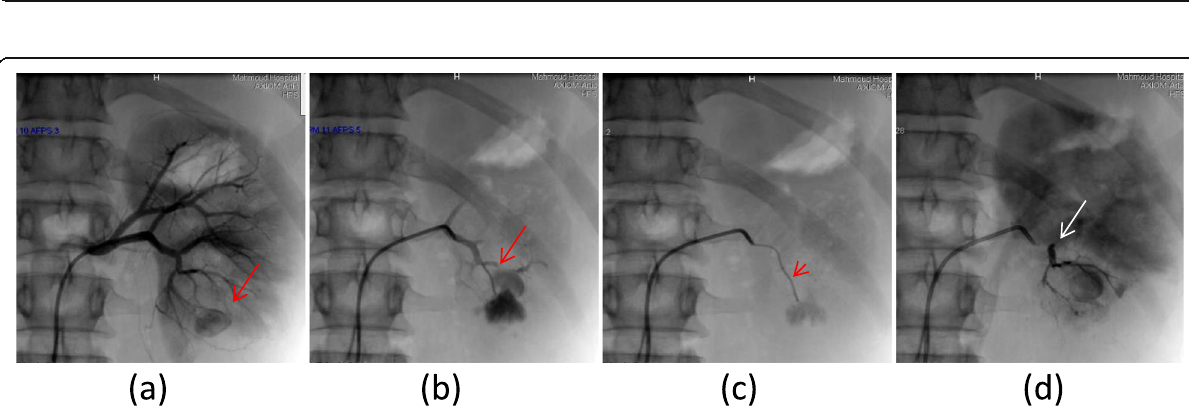
Fig. 6 A 28-year-old man had persistent massive hematuria due to a closed contusion of the left kidney in a car accident. Renal artery angiography with the Cobra catheter ( a ) shows the pseudoaneurysm in the lower zone of the left kidney (red arrow). Micro-catheter angiography was done keeping the catheter inside the aneurysmal sac ( c ) (arrow head). NBCA glue was injected by microcatheter to fill the aneurysm but spilled over the segmental branch (white arrow) ( d